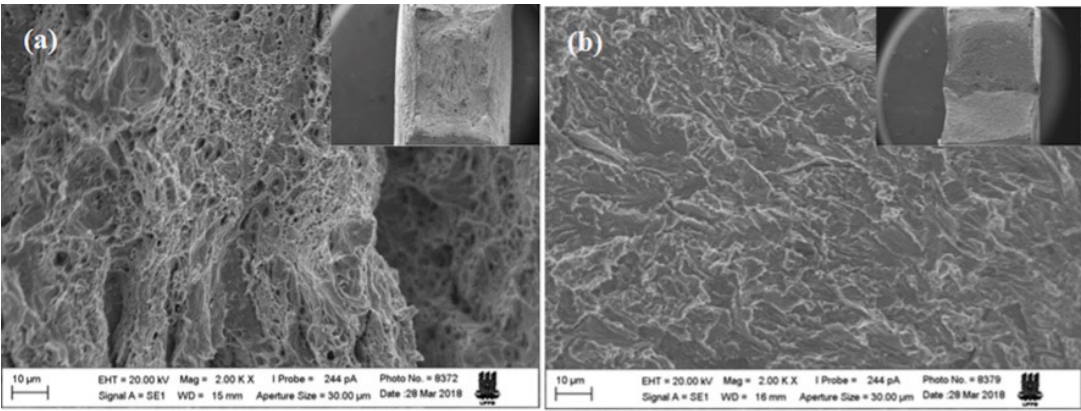
Figure 15. Fractography of the tensile test of the welded joint steel ASTM A182 F22 - Inconel 625 - steel ASTM A36. (a) without. (b) with